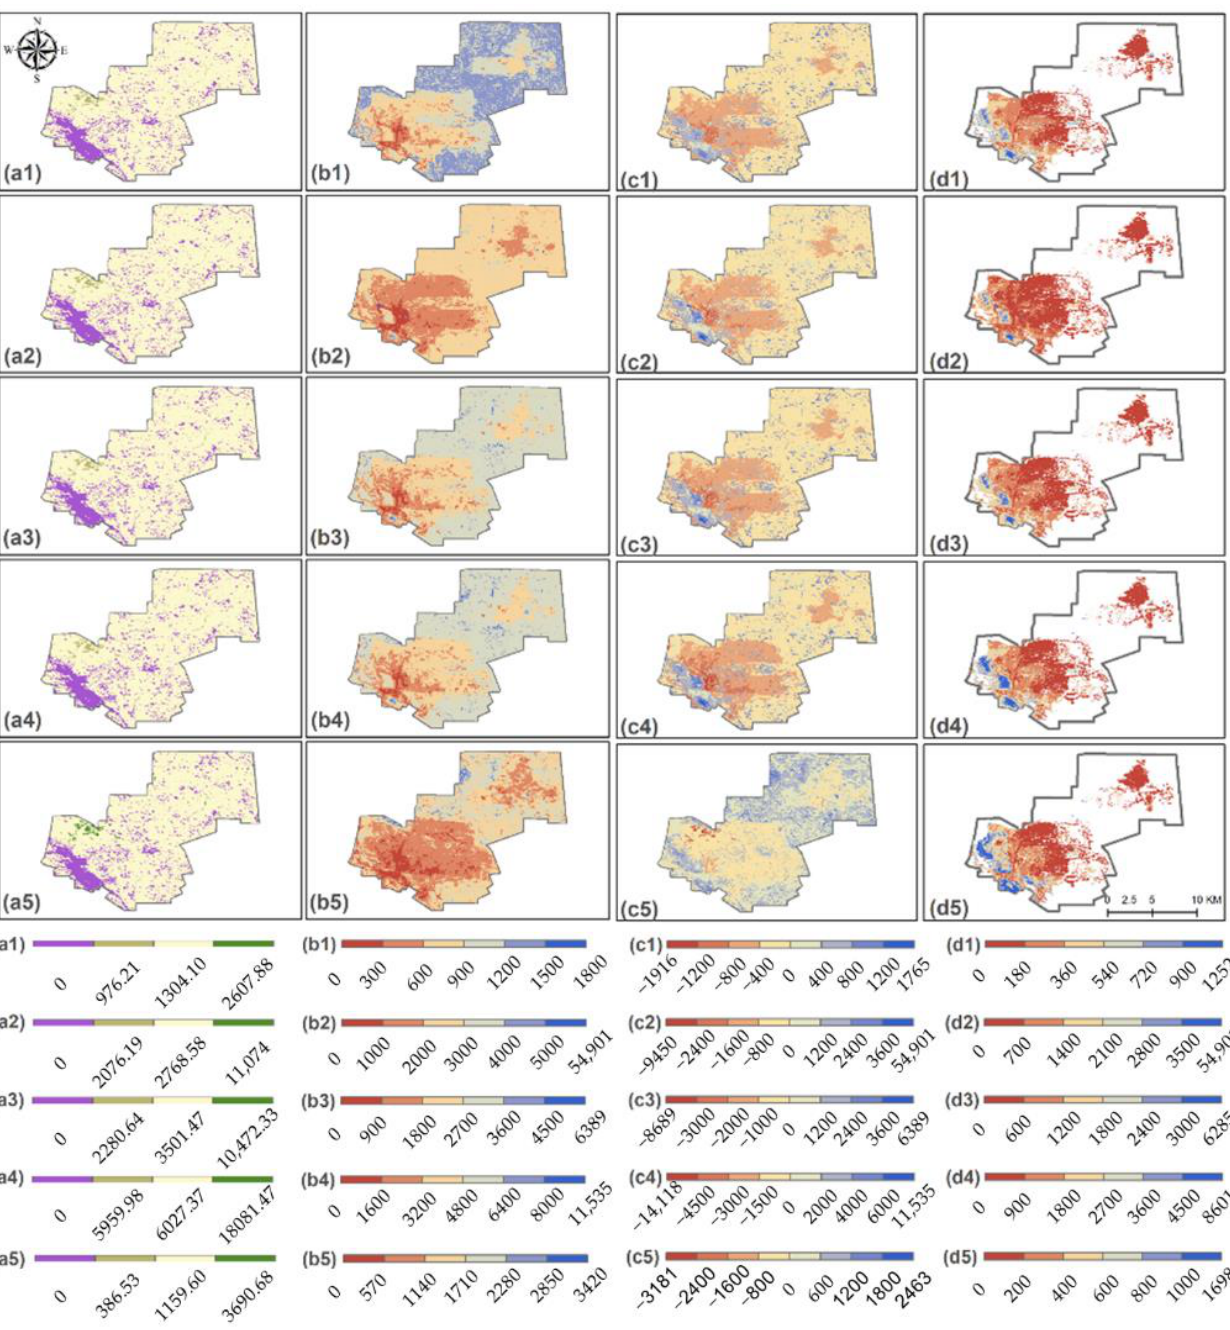
Figure 9. Changes in ECE for 5 ecological functions during 1986 – 2021. ( a1 – a5 ) Ideal ecological cumulative value (IECV), ( b1 – b5 ) real ecological cumulative value (RECV), ( c1 – c5 ) real ecological cumulative loss (RECL), ( d1 – d5 ) real restoration cumulative value (RRCV).